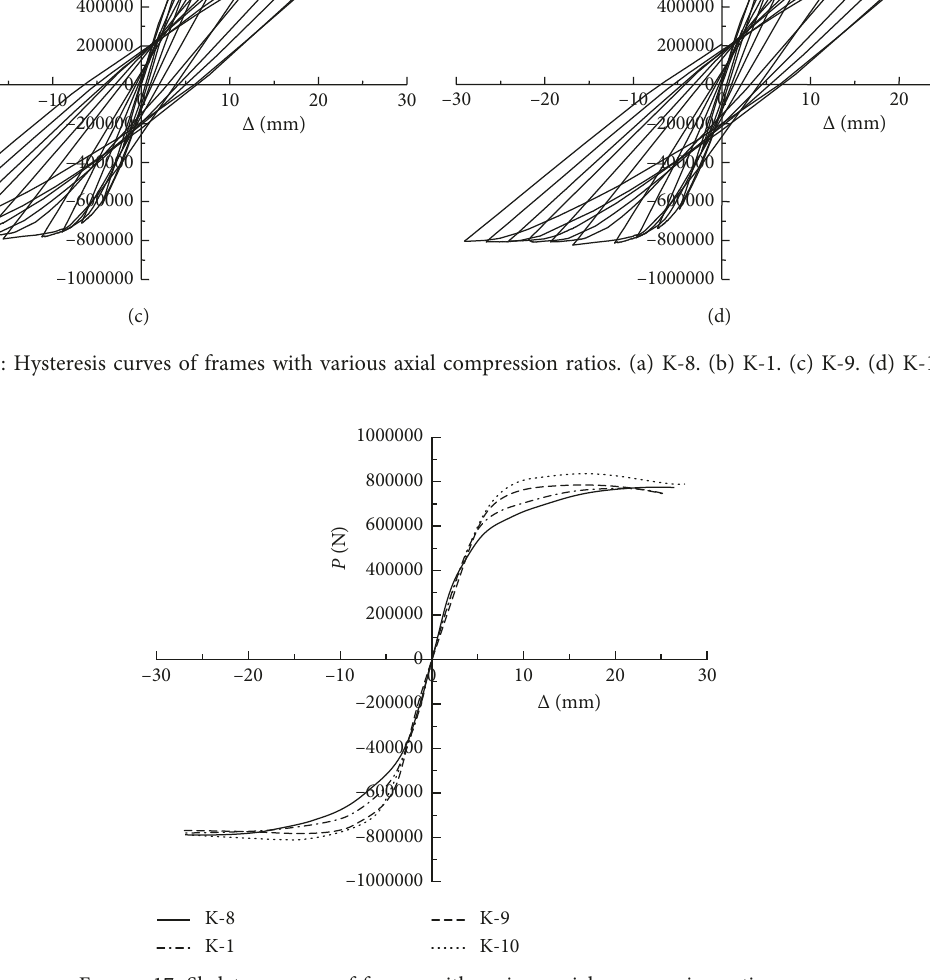
Figure 17: Skeleton curves of frames with various axial compression ratios.